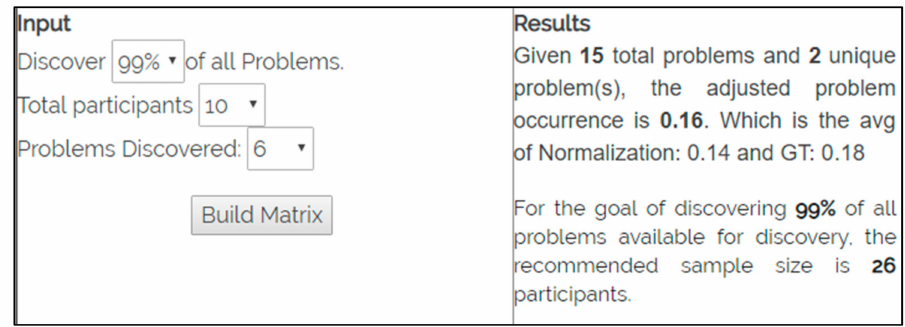
Figure 7. Estimated number of respondents based on the occurrence of problems